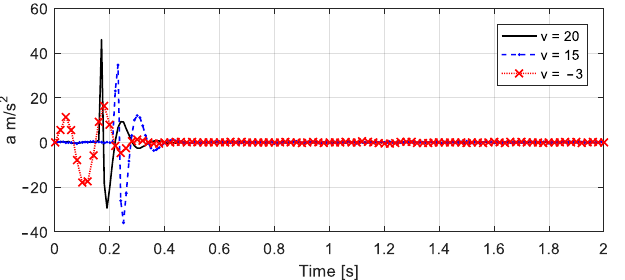
Figure 9. The accelerations of the rear wheel measured by S 2 with velocities of [20, 15 , − 3] m/s.